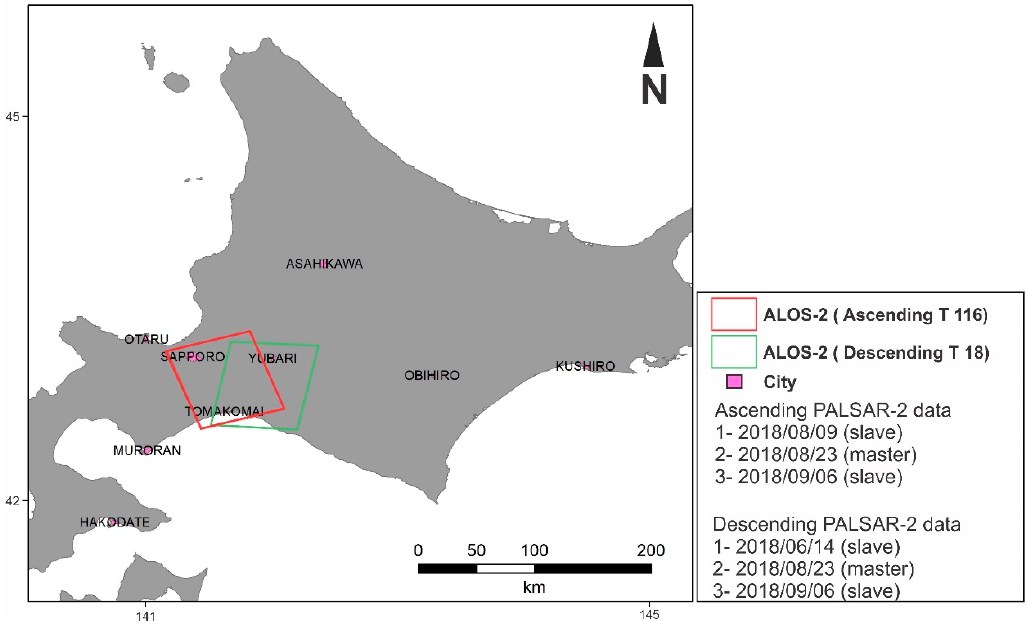
Figure 2. Footprints of ascending (red polygon) and descending (green polygon) acquired from the ALOS-2 satellite.